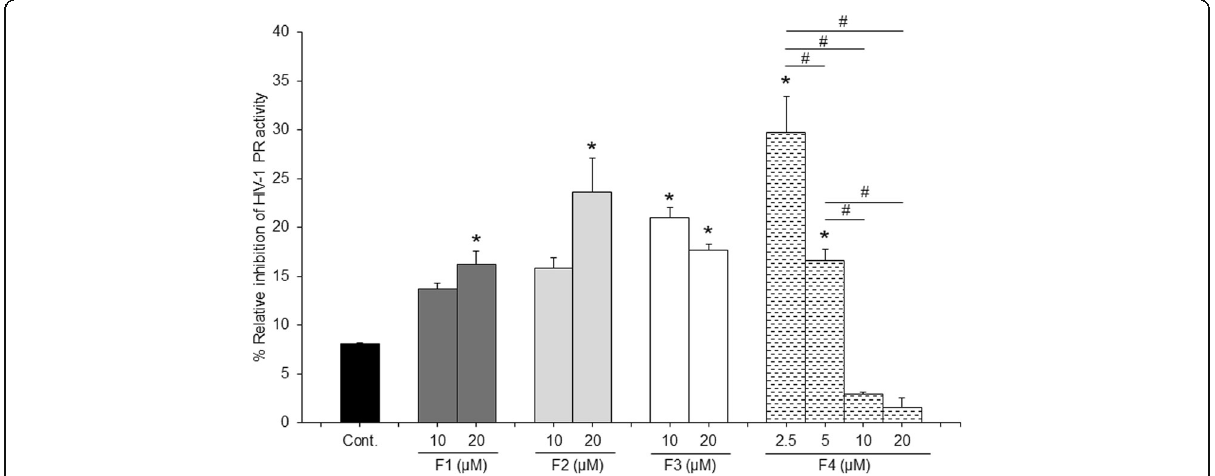
Fig. 4 Percent relative inhibition of HIV-1 PR activity of identified compounds: F1 (combination of linoleoyl, oleoyl, palmitoylglycerol and linoleoyl, oleoyl, stearoylglycerol), F2 (distearoyl, palmitoylglycerol), F3 (linoleic acid) and F4 (ergosterol). The error bars indicate the standard error of the means. * p < 0.05 compare to vehicle control. # p < 0.05 compared to other concentration of the same